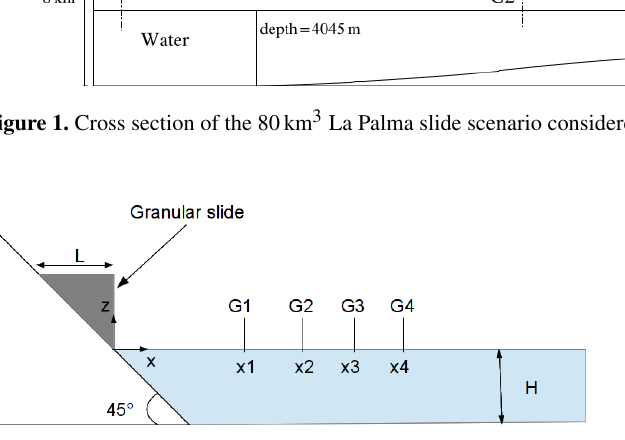
Figure 2. Sketch of the experiment performed in Viroulet et al.